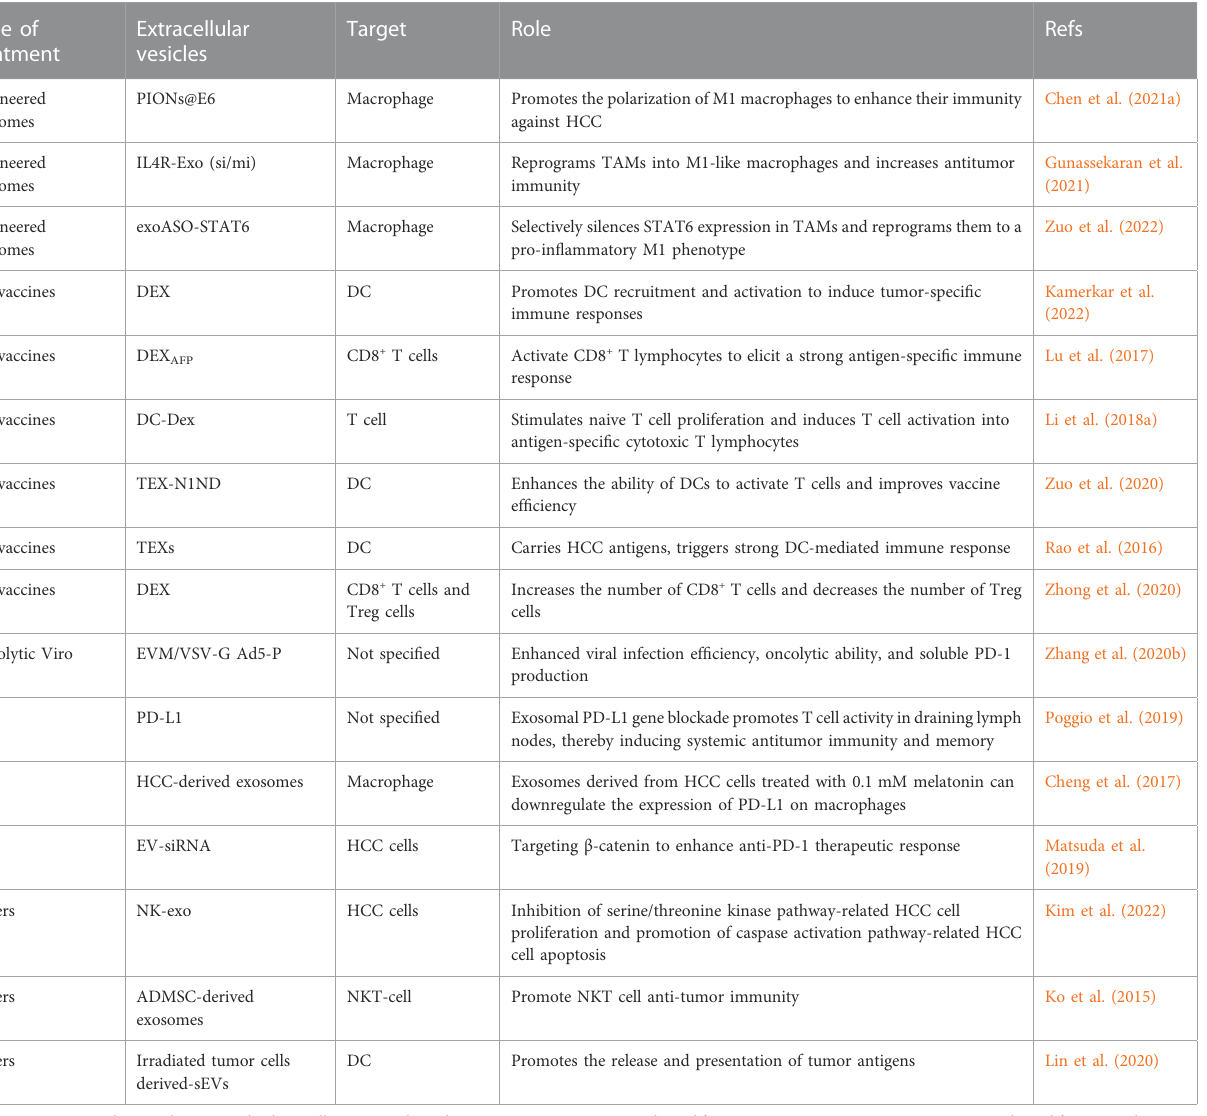
TABLE 3 Clinical applications of extracellular vesicles in HCC